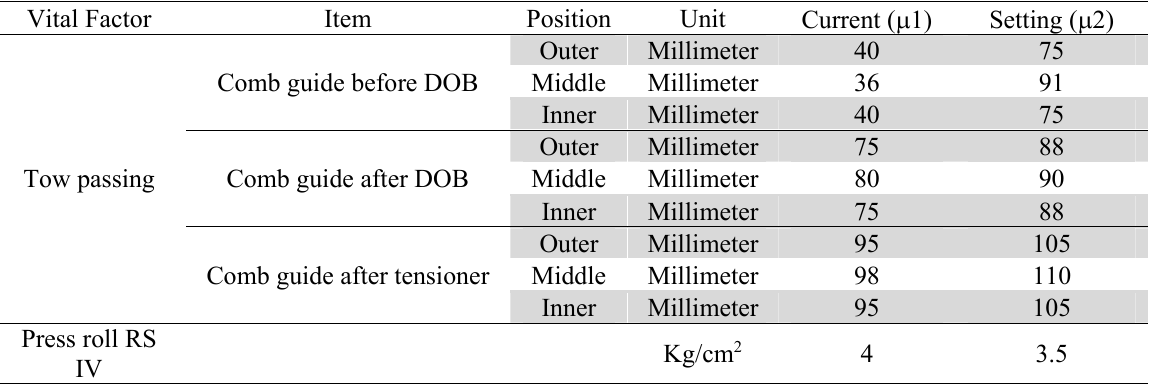
Vital Factor Item Setting (  )